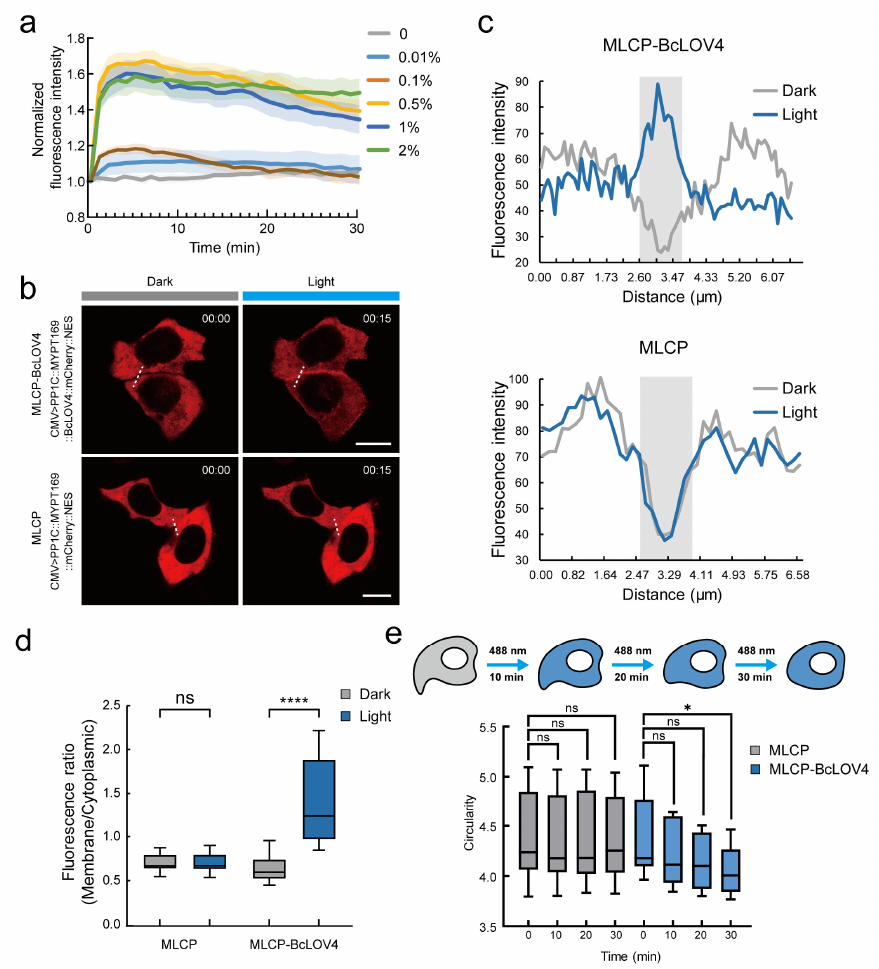
Figure 2. Validation of the MLCP ‐ BcLOV4 system in HeLa cells. ( a ) Quantitative statistics of fluorescence intensity change of HeLa cell membrane in the MLCP ‐ BcLOV4 ‐ expressed group within 30 min under stimulation of blue light at 0 to 2% intensity. The solid line and pale area are normalized statistics of the mean value and SEM of the change in the fluorescence intensity of the cell membrane. n = 10 cells; ( b ) Representative images of the expression of the MLCP ‐ BcLOV4 ‐ expressed group (CMV>PP1c::MYPT169::BcLOV4::mCherry::NES, top row) and the MLCP ‐ expressed group (CMV>PP1c::MYPT169::mCherry::NES, bottom row) in HeLa cells. The left is the image in the dark and the right is the image after 15 min of illumination under 488 nm blue light. Scale bar, 10 μ m; ( c ) Quantitative statistics of fluorescence intensity at the white dotted line in panel b. The gray line is the statistical graph in the dark state and the blue line is the statistical graph after 15 min of blue light irradiation. The light gray area is the cell boundary; ( d ) Quantification of membrane ‐ to ‐ cytoplasm ratio of mCherry signal fluorescence ratios of the MLCP ‐ BcLOV4 ‐ expressed group and the MLCP ‐ expressed group after 15 min of exposure to 0.5% blue light. ****, p < 0.0001 (student’s t ‐ test). n = 20 cells; ( e ) Schematic diagram of blue light treatment of HeLa cells with MLCP ‐ BcLOV4 system. The circularity (ratio of the perimeter to the square root of its area) of the cell section through the nuclear geometric center in the MLCP ‐ BcLOV4 ‐ expressed group and MLCP ‐ expressed group changed at 10, 20, and 30 min after blue light stimulation. *, p < 0.05 (student’s t ‐ test). n = 10 cells.